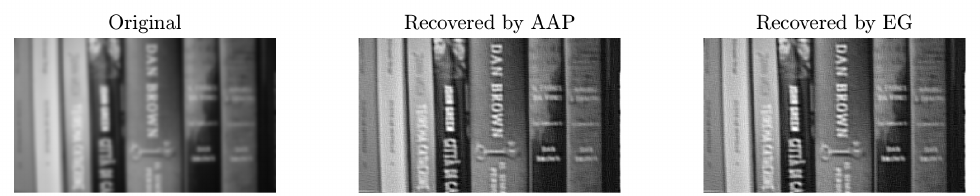
Figure 10. Image naturally blurred taken frontally by a digital camera through an out-of-focus lens. From left to right: Recorded image, image deblurred by the adapt-and-project method and image deblurred by the exponentiated-gradient